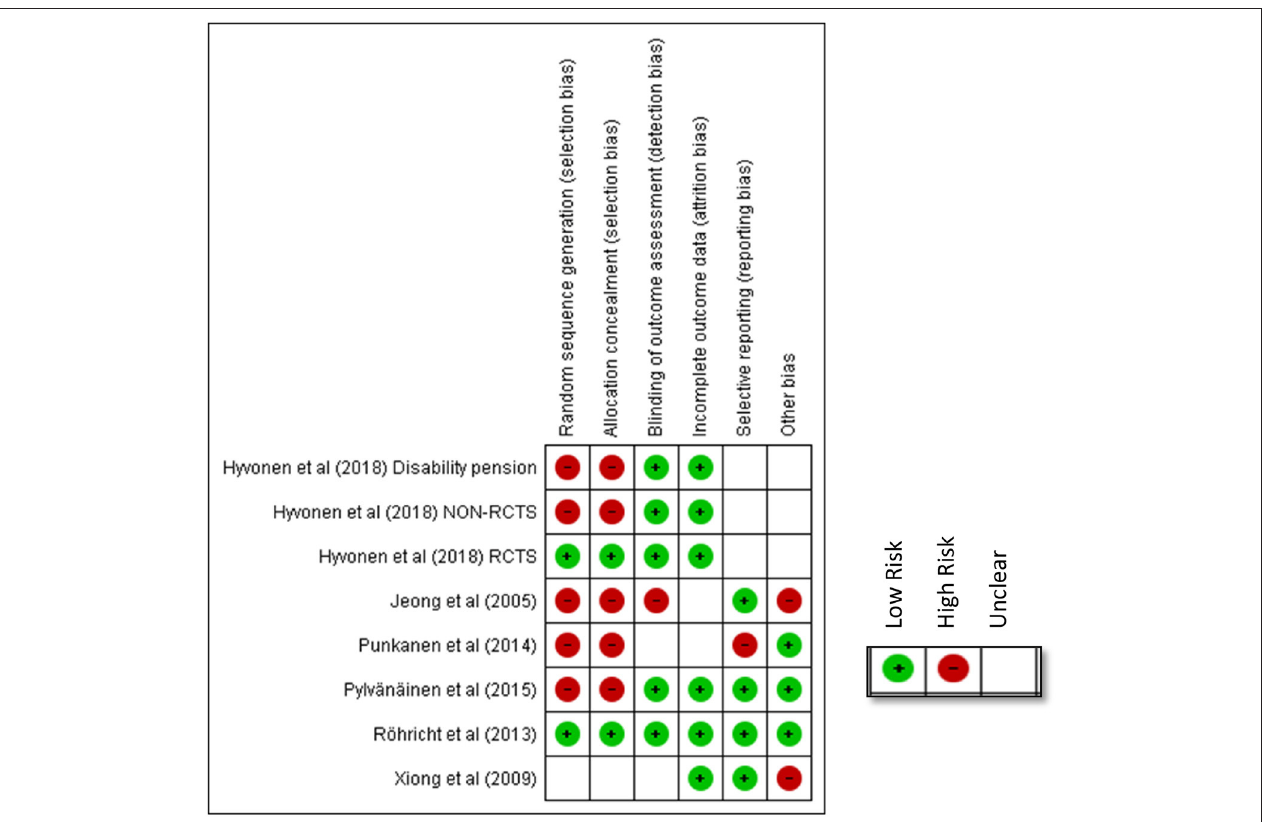
FIGURE 5 | Risk of bias for each included